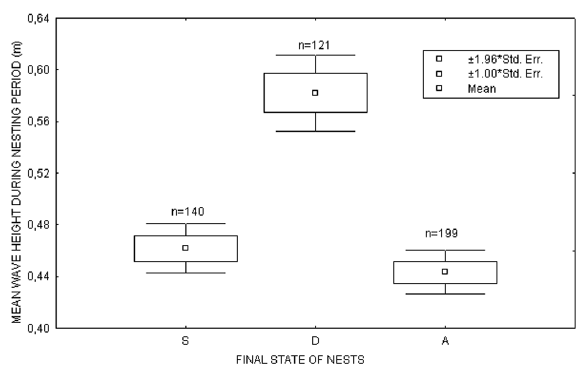
Fig. 3. – Plot of means and standard errors of wave height during the nesting survey period for the total number of nests reaching any of the final states (S=successful nests; D=destroyed nest and A=abandoned nests; n=total number of nests).